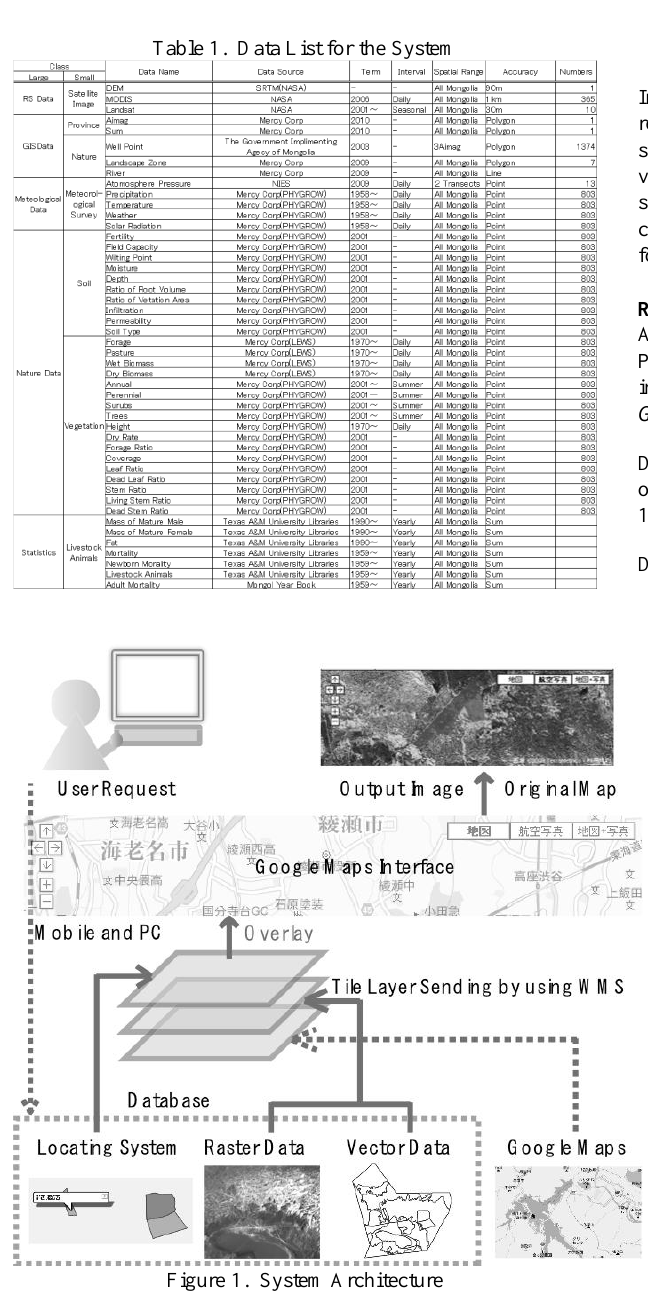
Figure 1. System